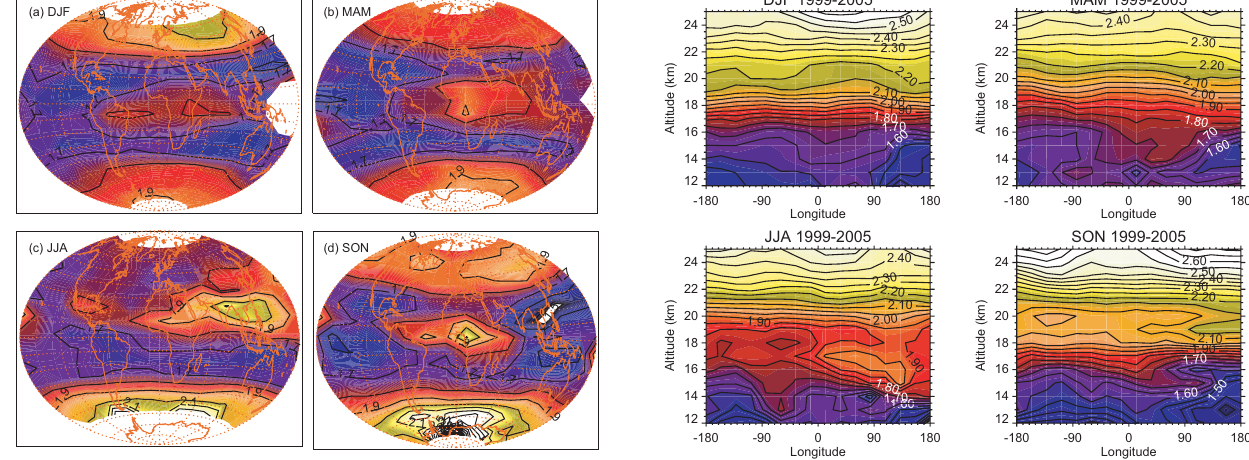
Fig. 9. Seasonal depictions of median aerosol extinction coefficient ratio (relative to molecular) for SAGE II observations between 1999 and 2005 between 15 and 45 ◦ N. Contours are drawn every 0.05 from 1.4 to